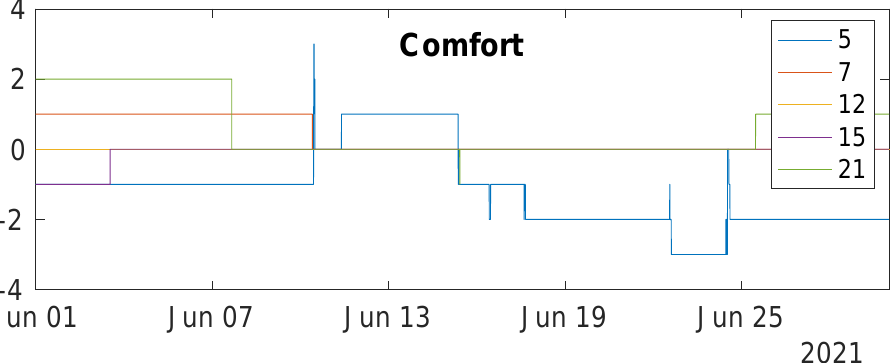
Figure 8. Comfort feedback recorded by PCFNs deployed in iHub over a